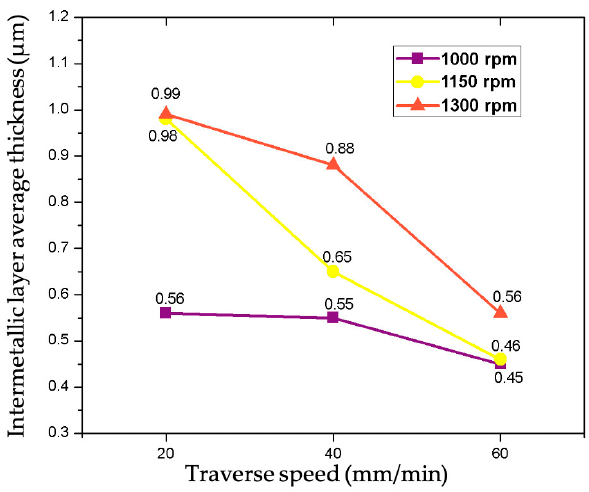
Figure 9. Influence of tool rotational speed and traverse speed on the average thickness of the intermetallic layer.